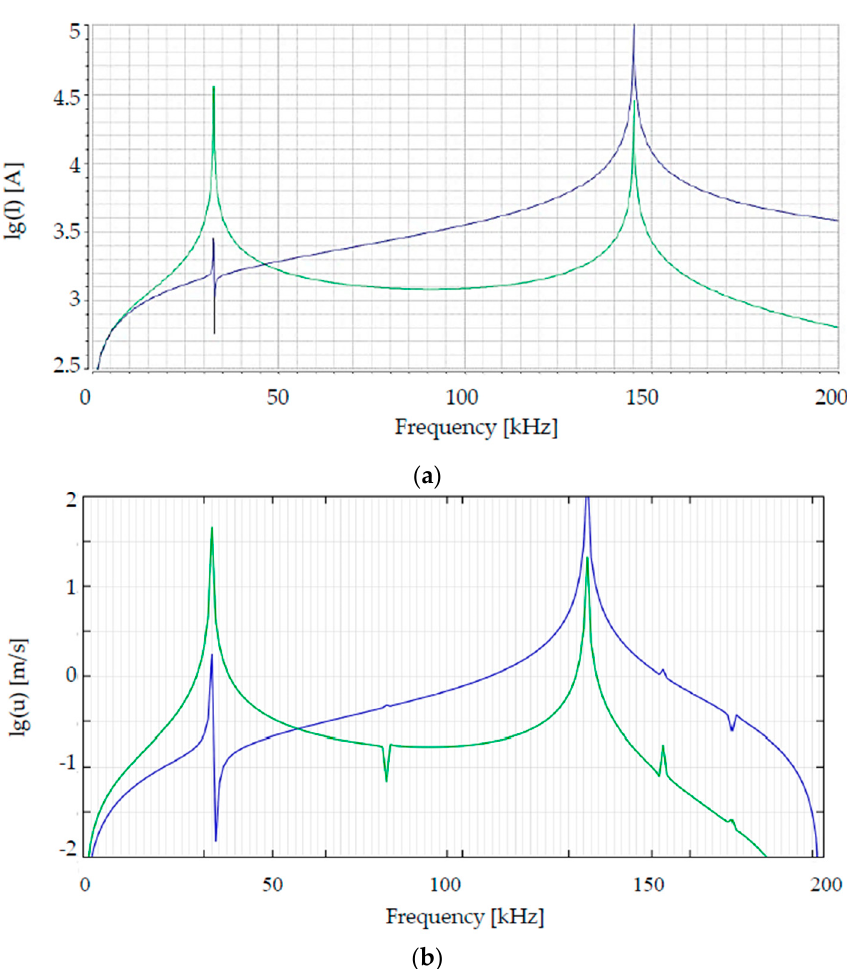
. .  J  J (blue) and (green) of design S1 calculated by ( a ) analytic ϑ a (blue) and ϑ m (green) of design S1 calculated by ( a ) analytic a m